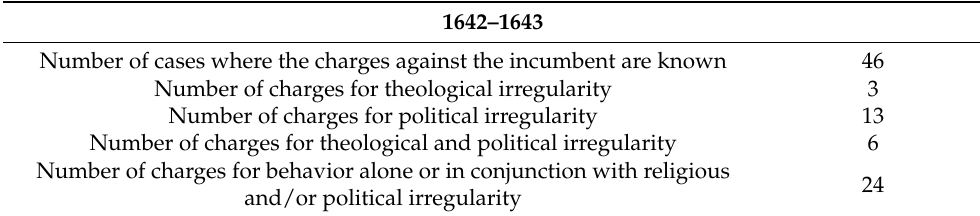
Table 2. Charges against